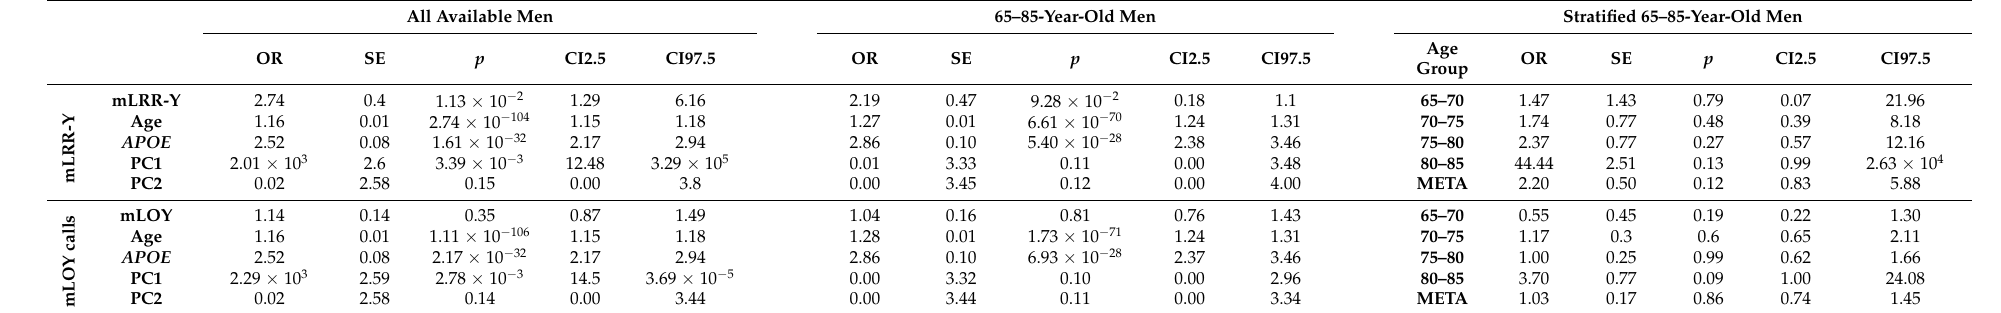
Table 1. Logistic regression results using mLRR-Y and mLOY calls as predictors for AD status. We defined three experimental setups: (a) all men with available age at DNA sampling, (b) 65–85-year-old men, and (c) a stratification of 65–85-year-old men into age groups (65–70, 70–75, 75–80, and 80–85 years old). We adjusted models by age at blood sampling, APOE genotype, and PCs. In the age-stratified models, only the effect of mLRR-Y or mLOY are displayed. The 95% confidence interval is presented as the 2.5% quantile (CI2.5) and the 97.5% quantile (CI97.5). OR, odds ratio; SE, standard error. All Available